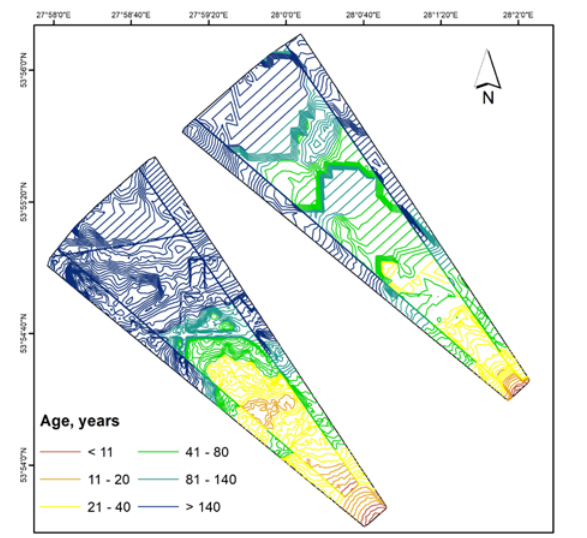
Figure 5. Age of spruce in reaching the maximum permissible height with the color